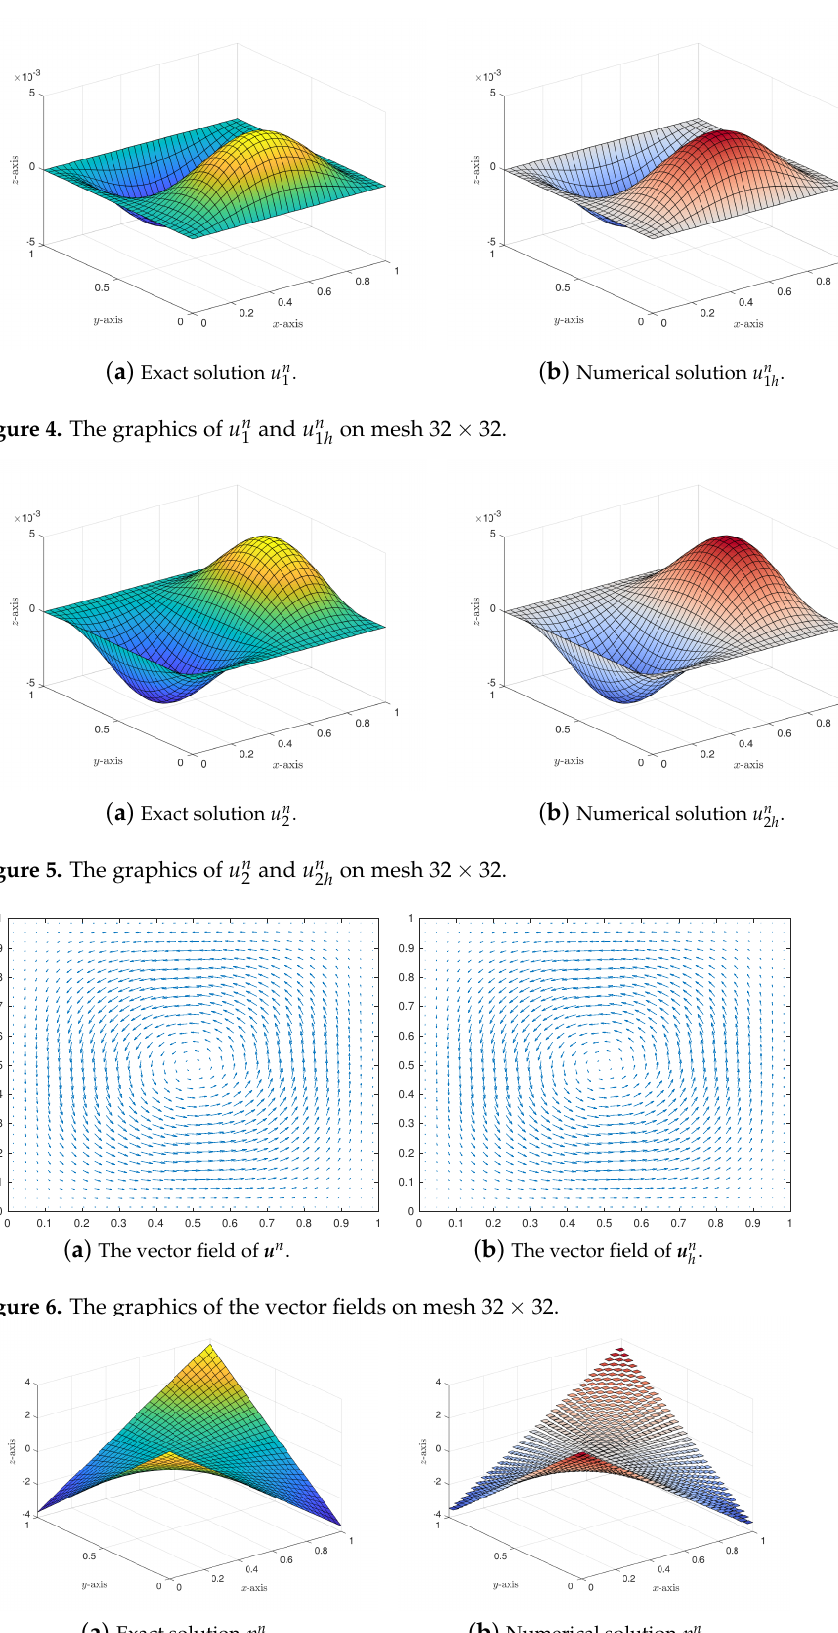
Figure 7. The graphics of p n and p n